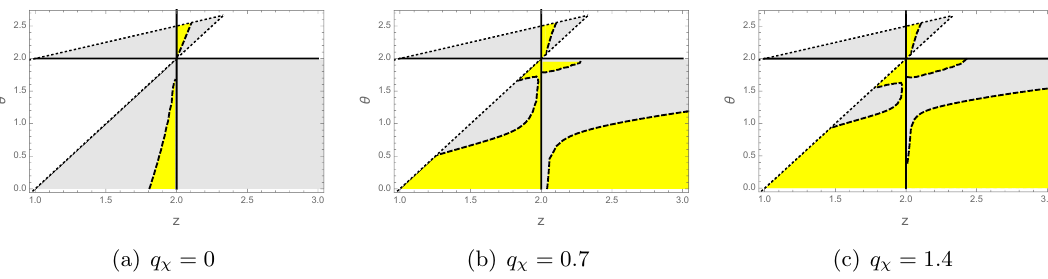
Figure 7 . WL (yellow) vs WAL(gray) in the validity regime. Other parameters are same as in (cid:12)gure 6 and T = 0 :